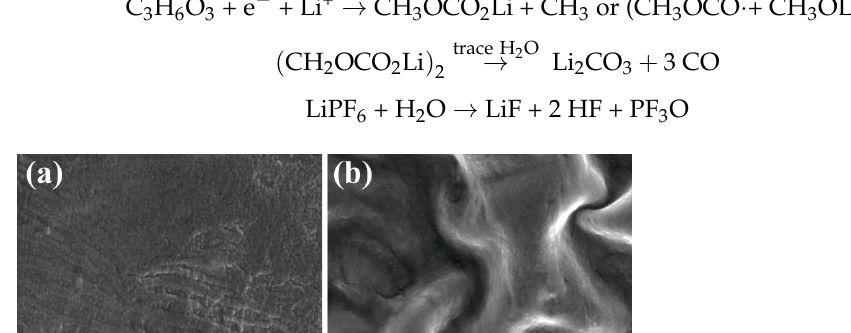
Figure 1. SEM images of lithium metal foils: ( a ) original; ( b ) RT-1D battery; ( c ) RT-7D battery; ( d ) 55 °C-7D battery.